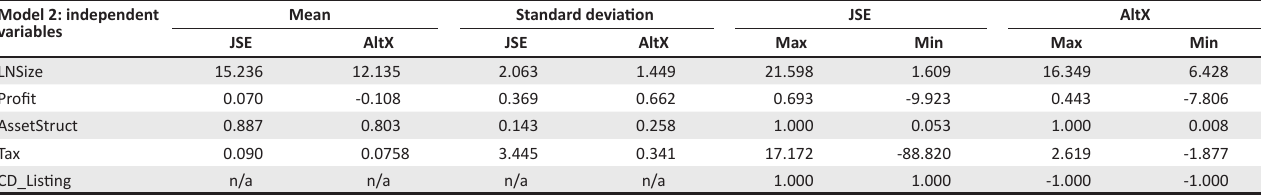
TABLE 5: Descriptive statistics of the independent variables in Eqn 2. Model 2: independent